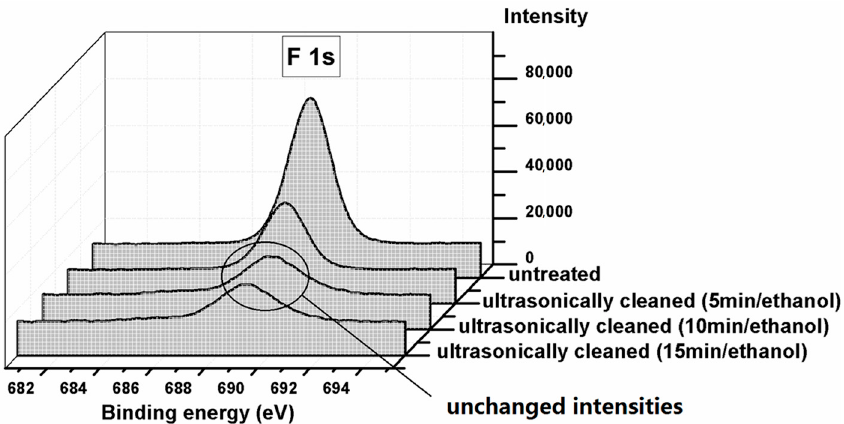
Figure 8. XPS spectra of F 1s on FAS-grafted alumina membrane before and after ultrasonic cleaning in ethanol.